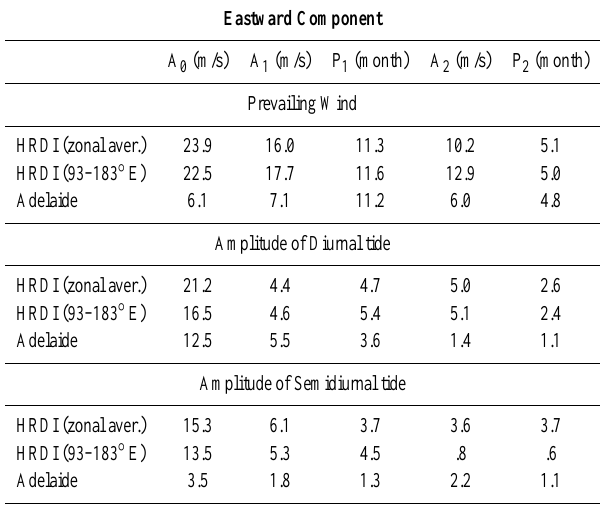
Table 2. Annual mean annual (A1, P1) and semiannual (A2, P2) harmonics (amplitude, phase) corresponding to the prevailing (di- urnal mean), diurnal and semidiurnal components of the eastward wind (top) and northward wind (bottom) component for 35 ◦ –40 ◦